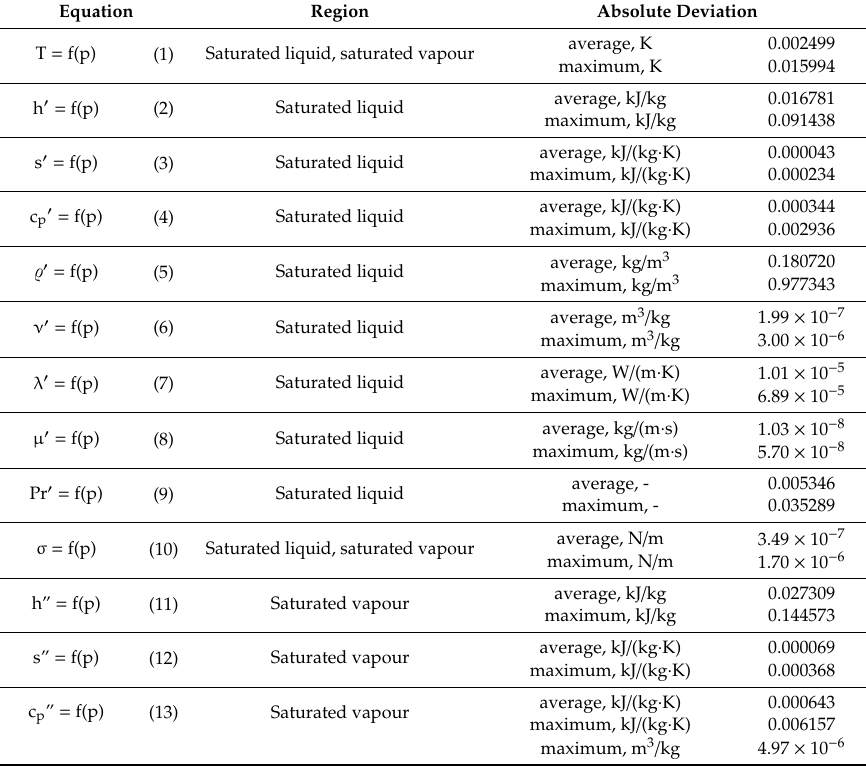
Table 12. Absolute deviations between the values obtained from CoolProp 5.1.1 and the calculated values for the R1234ze(E)